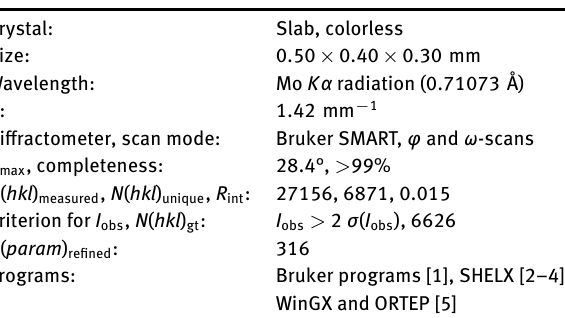
Table 1: Data collection and